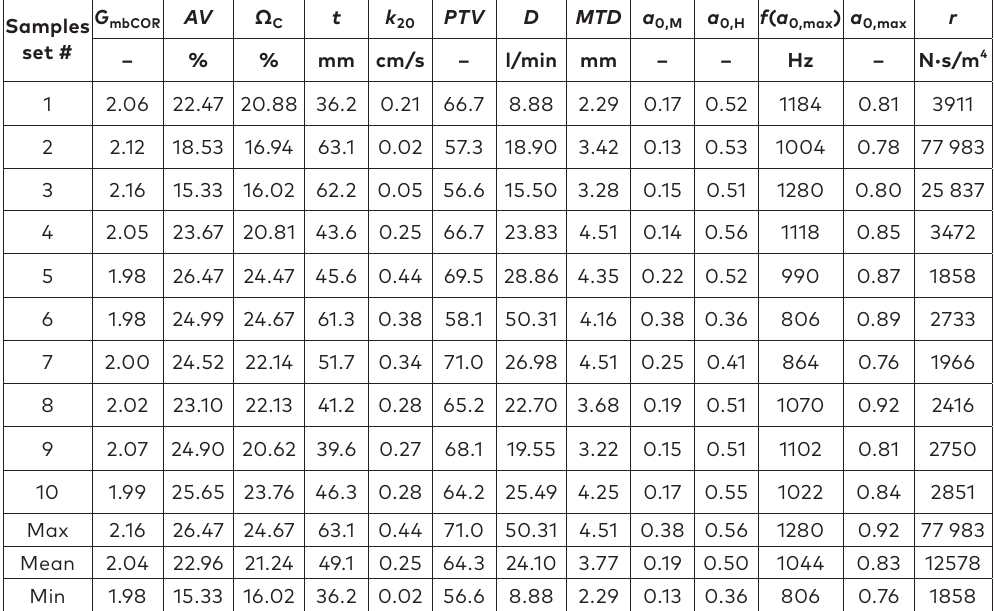
values from samples. Table 2. Main results from in-lab and on-site